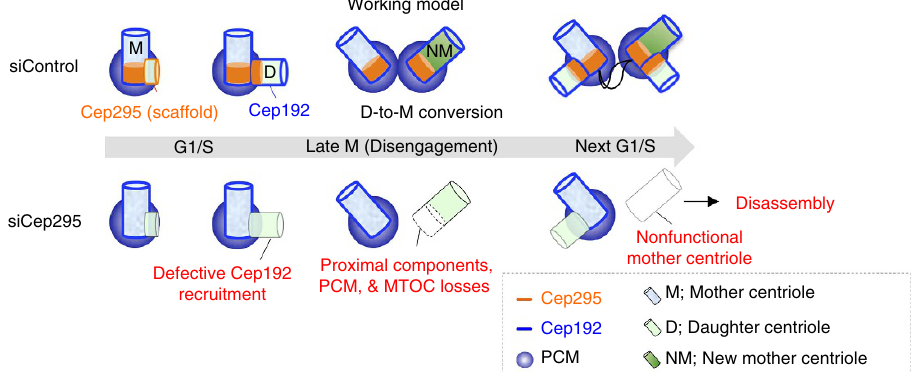
Figure 7 | Cep295 ensures daughter-to-mother centriole conversion via Cep192 recruitment onto the newly formed daughter centriole wall. A speculative model of the role of Cep295 in centriole biogenesis. Cep295 promotes recruitment of Cep192 onto the wall of a newly formed daughter centriole. Cep295 is also critical for the integrity of the proximal part of the daughter centriole and for stability of the resulting centriole in the next cell cycle. The events coordinated by Cep295 are thus critical for the ability of a new mother centriole to duplicate, recruit PCM components and act as the MTOC.